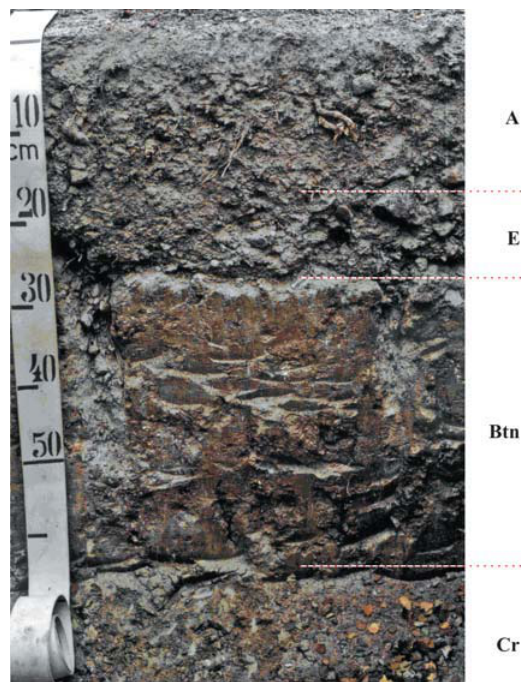
Figura 1. Perfil CJ-3 - Planossolo Háplico eutrófico solódico, em ambiente conservado de Jataúba,